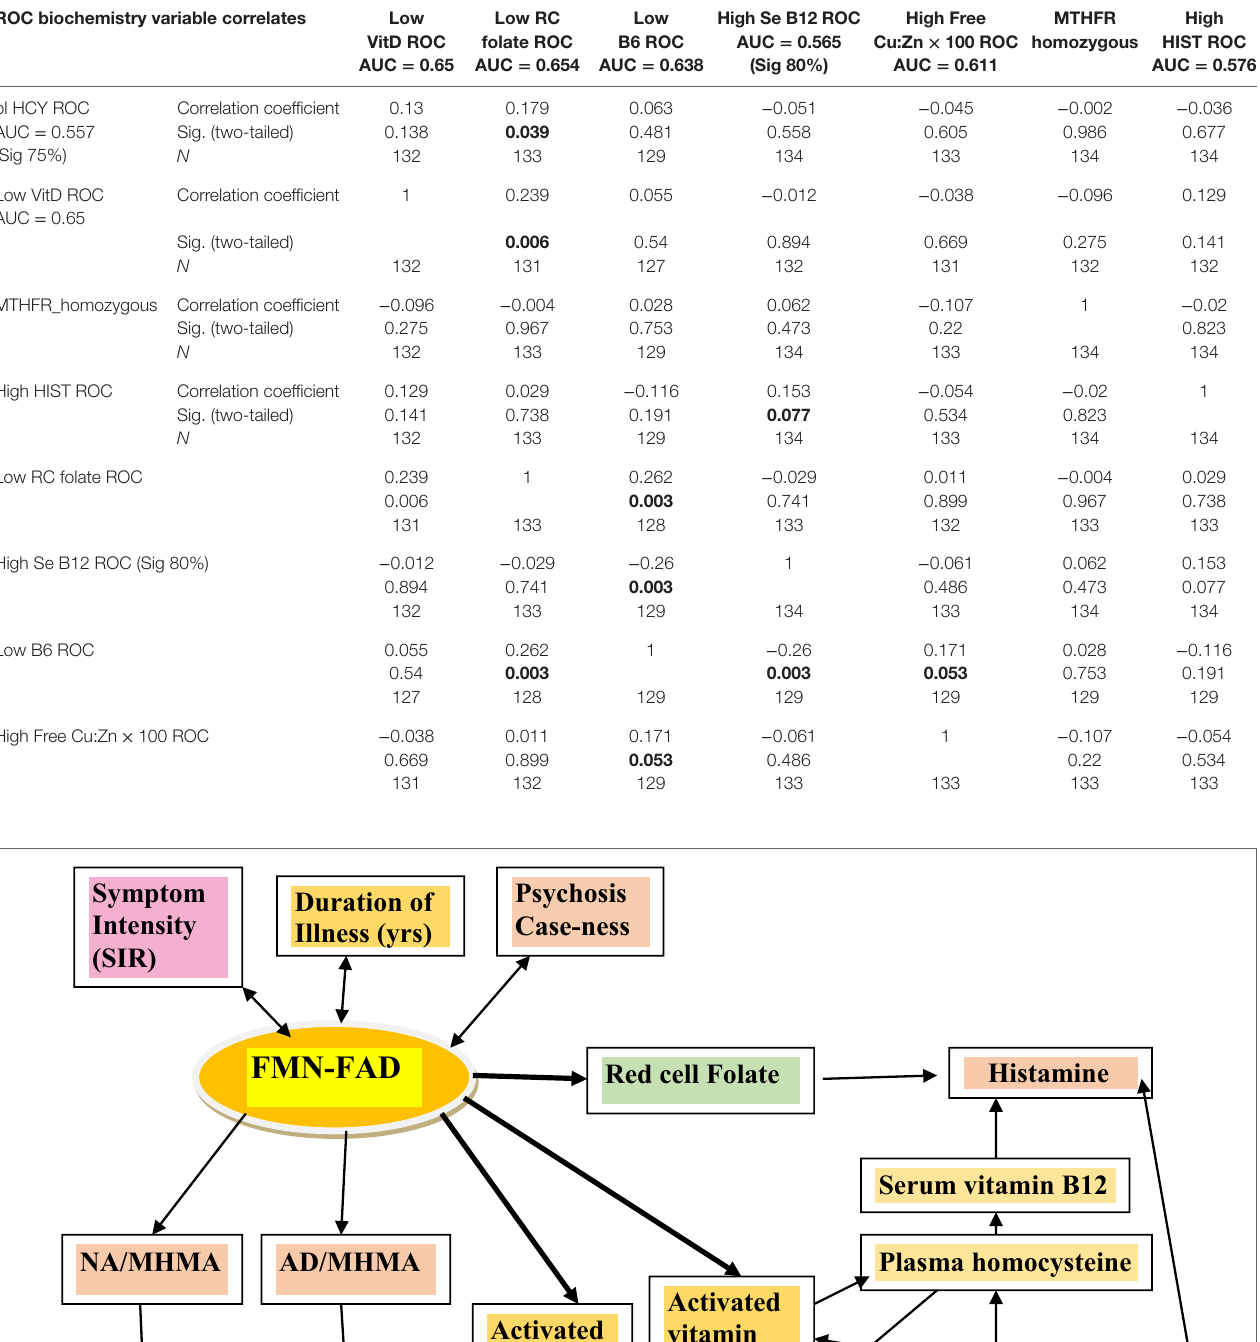
TaBle 4 | Total sample correlation matrix for biochemistry variables and rOcs in relationship to each other. rOc biochemistry variable correlates